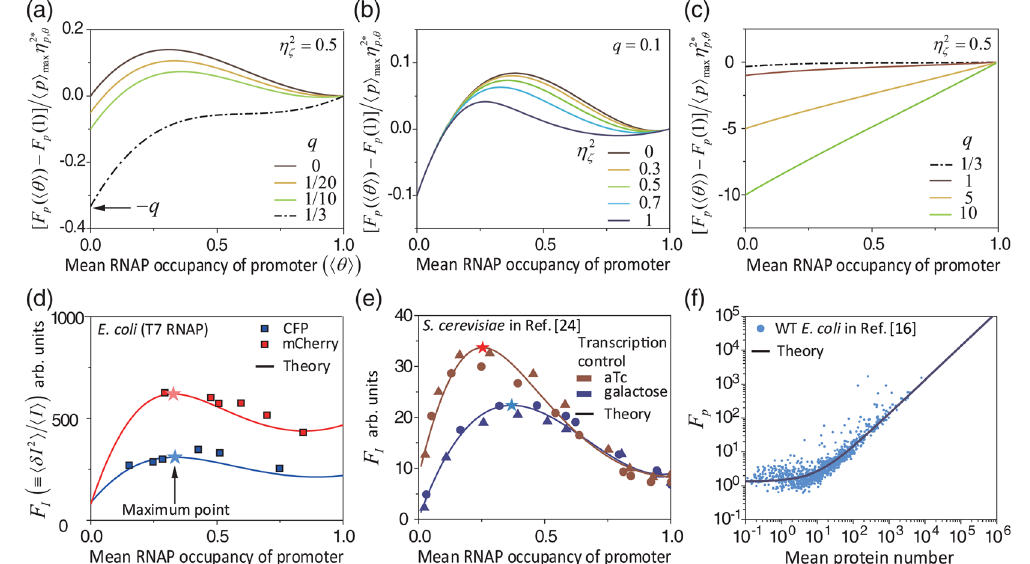
FIG. 5. Unified quantitative explanation of various patterns in the Fano factor data observed across different gene expression systems. = η 2 (cid:4) Two parameters, q ð ≡ η 2 Þ and η 2 ζ , determine the pattern in the dependence of Fano factor F p on h θ i [Eq. (G5)]. (a) When q < 1 = 3 , p;k p; θ θ iÞ is a nonmonotonic function with the single maximum at h θ i ¼ h θ i ∗ ð < 2 = 3 Þ . (b) h θ i ∗ decreases with η 2 F p ðh θ iÞ monotonically increases with h θ i . (d),(e) Dependence of the intensity Fano factor F F p ðh synthetic E. coli with T7 RNAP transcription (d) and for yEGFP gene expression in S. cerevisiae under two different transcriptional controls, reported in Ref. [24] (e). In (d), the theory curves are the results of Eqs. (6) and (7) with the predetermined parameters values extracted from the analysis in Fig. 3 (Table I). Equations (6) and (7) also provide a unified quantitative explanation of all the Fano factor data shown in (e) with a small number of adjustable parameters (Table I of Supplemental Material [32]). The extracted value of q is far smaller than 1 = 3 for data in (d) and (e), where the Fano factor has the maximum at about h θ i ∗ ≅ 3 − 1 ð 2 − value of parameter q means that the extrinsic noise originating from RNAP-promoter association step makes the dominant contribution to the total extrinsic protein noise. In the opposite case, q becomes very large and the Fano factor becomes a linear function of h θ i , which is the case for the abundant proteins in the wild-type E. coli in (f) [see also Figs. 13(b) and 14 in Supplemental Material [32]]. See text for θ iÞ the analytic expression of F p ðh